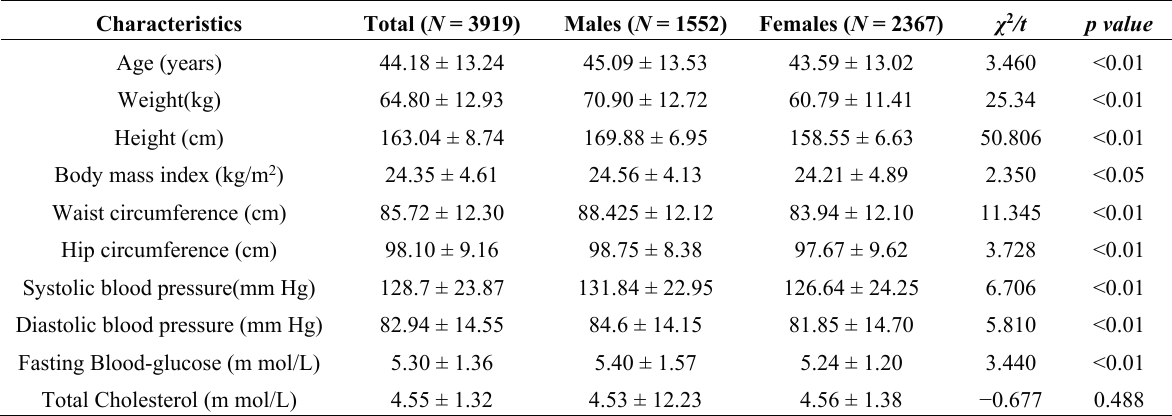
Table 1. Characteristics of the study population and prevalence of cardiovascular risk